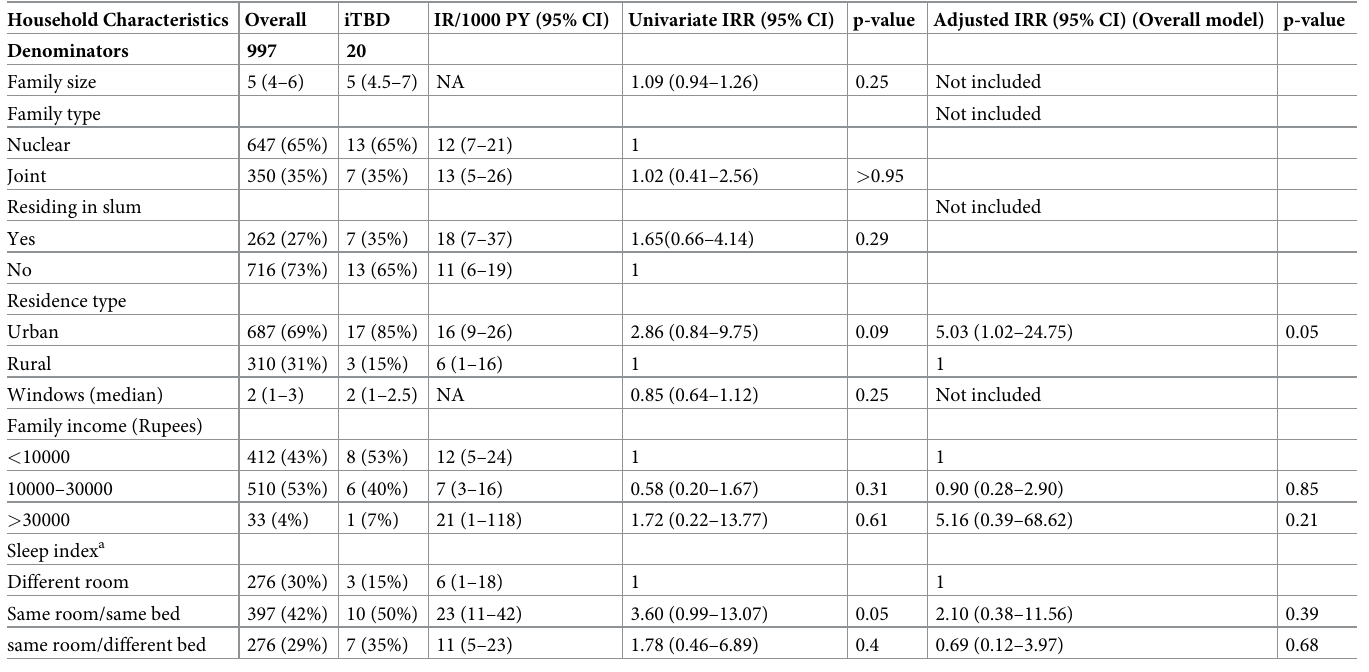
Table 3. Baseline characteristics of the household and risk factors for incident TB disease among household contacts of adult pulmonary TB patients in India. Household Characteristics Overall